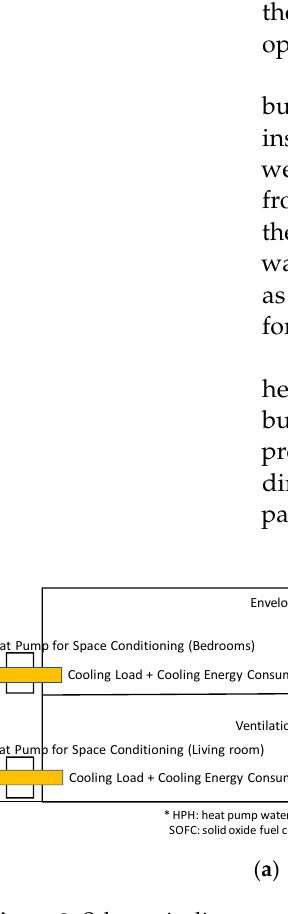
Figure 2. Schematic diagram of the heat release defined in this study for ( a ) the cooling season and ( b ) the heating season.